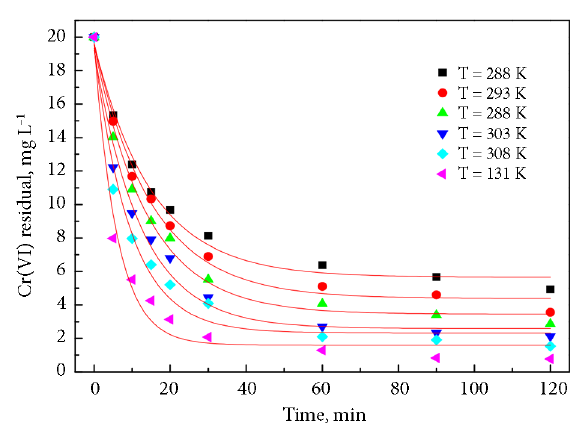
Figure 7. Removal of Cr(VI) by PPN2 at different temperatures. Reaction conditions: 50 mL of 20 mg L −1 Cr(VI) solution, pH = 3.88, and reaction time 120 min. Lines represent the two-parameter pseudo-first-order decay